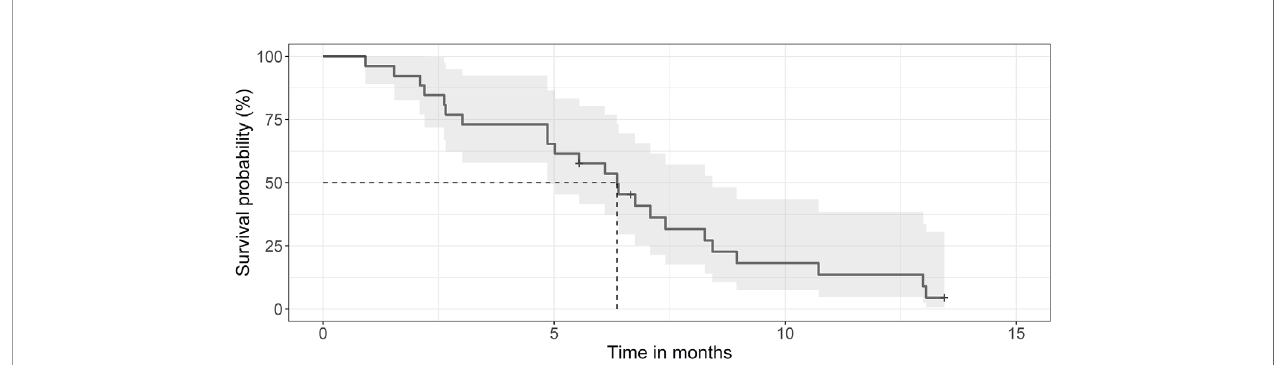
FIGURE 1 | Kaplan-Meier curve for survival of patients after SRT. The median survival was 6.4 months (0.95 LCL – 0.95 UCL: 4.8 – 8.4 months) for the 26 patients after the end or